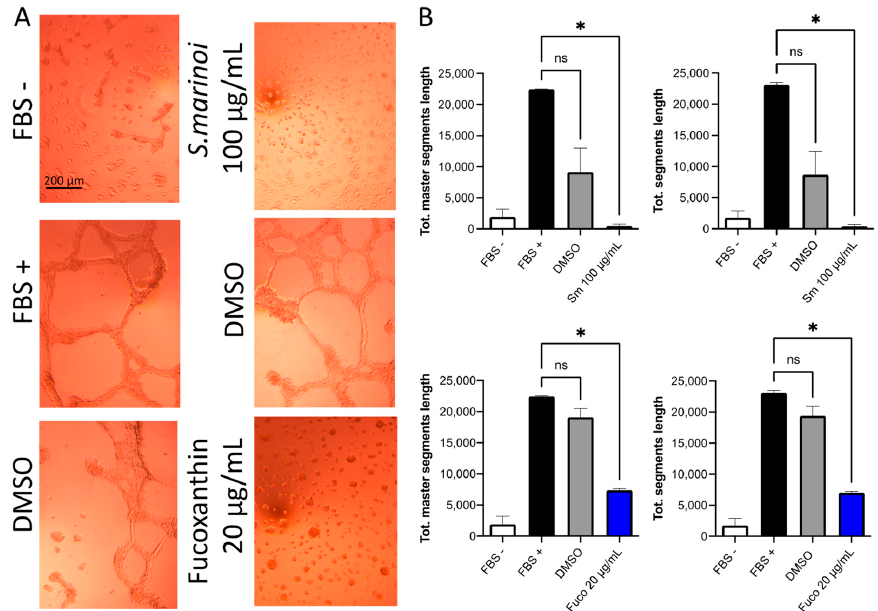
Figure 4. Effects of S. marinoi extract and fucoxanthin on DU145 tumor cell vascular mimicry. DMSO, at the corresponding dilutions, was used as vehicle control for both Sm (100 µ g/mL) and Fuco (20 µ g/mL). ( A ) Photographs of vascular mimicry structures were taken at 10 × magnification, representative images are shown, scale bar: 200 µm. ( B ) Bar graphs are shown (ImageJ software and Angiogenesis Analyzer tool). Data are shown as mean ± SEM, one-way ANOVA, ns = not significant, * p < 0.05, ** p < 0.01; vs. FBS+ ( n = 4).